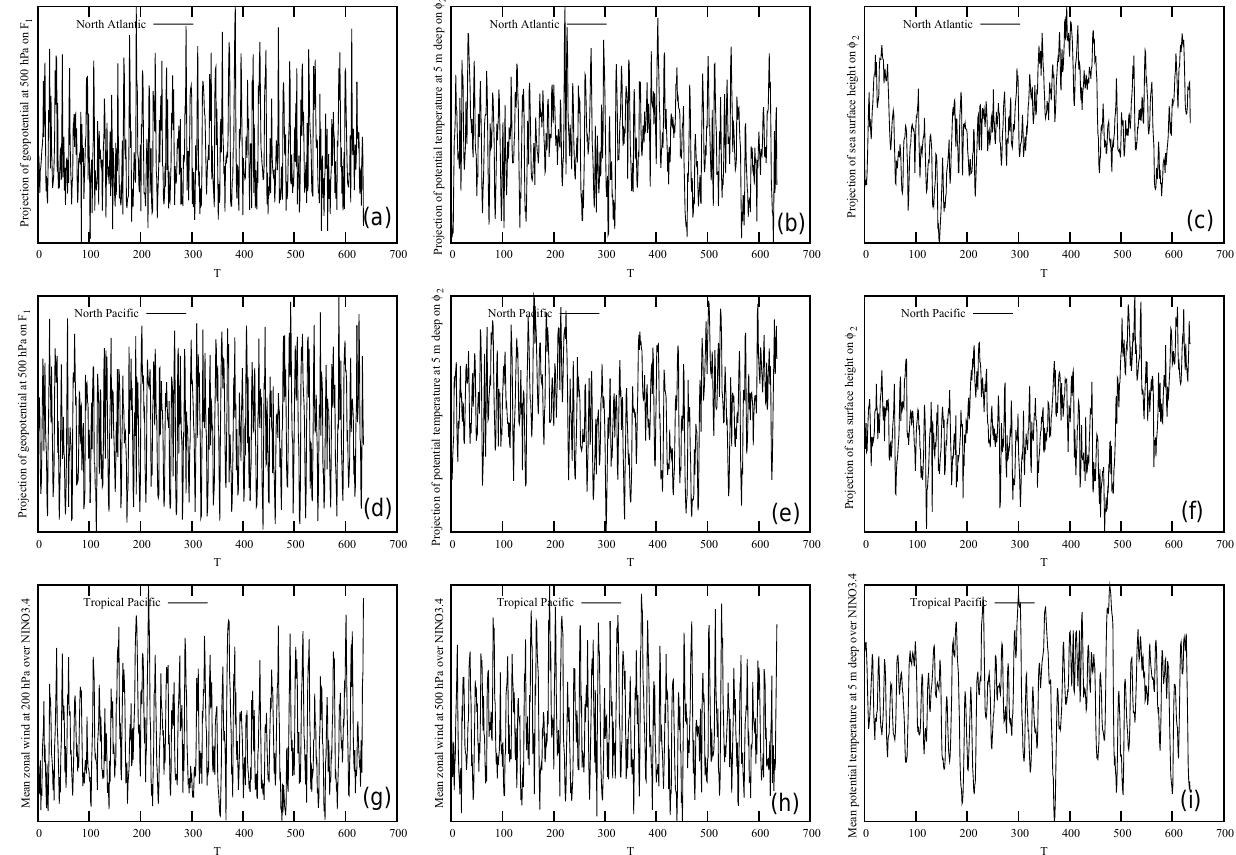
Figure 2. Monthly time series of the projections of the Atlantic, Pacific and tropical fields on the dominant modes of the dynamics, as obtained from the ORAS4 ocean reanalysis and the ERA-20C atmosphere reanalysis. (a–c) The geopotential at 500hPa projected on F 1 , the ocean potential temperature at 5m deep projected on φ 2 and the sea surface height projected on φ 2 for the Atlantic. (d–f) As for the top row but for the Pacific. (g–i) Zonal velocity at 200 and 500hPa, and the ocean potential temperature at 5m deep averaged over the Nino3.4 region. All time series are